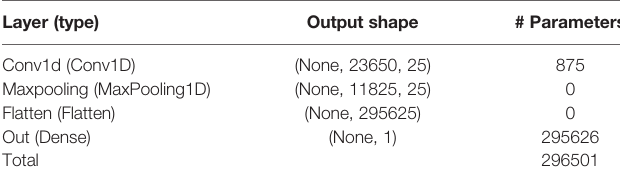
TABLE 4 | Layer name and type, output data shape of the layer, and number of trainable parameters per layer for the model with the Bayesian optimized model averaged hyperparameters using the pig raw phenotype data.